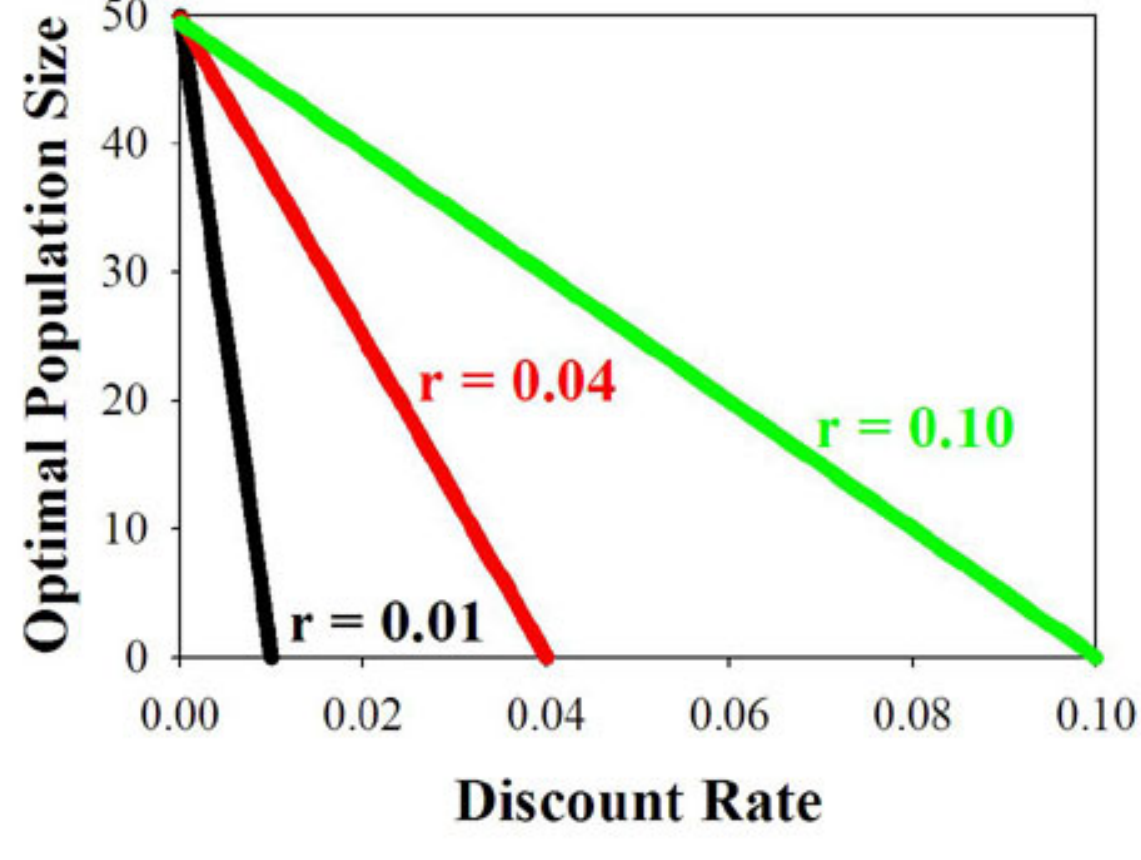
Fig. 1. Optimal population size vs. discount rate for a renewable resource, where the CBA is computed using simple exponential discounting. Results are shown for three values of the population growth parameter, r. For a given value of r, the optimal population size decreases from the maximum sustainable yield to zero as the discount rate increases up to r. The plot shows the log of equation 12, App. 1, for three values of r with